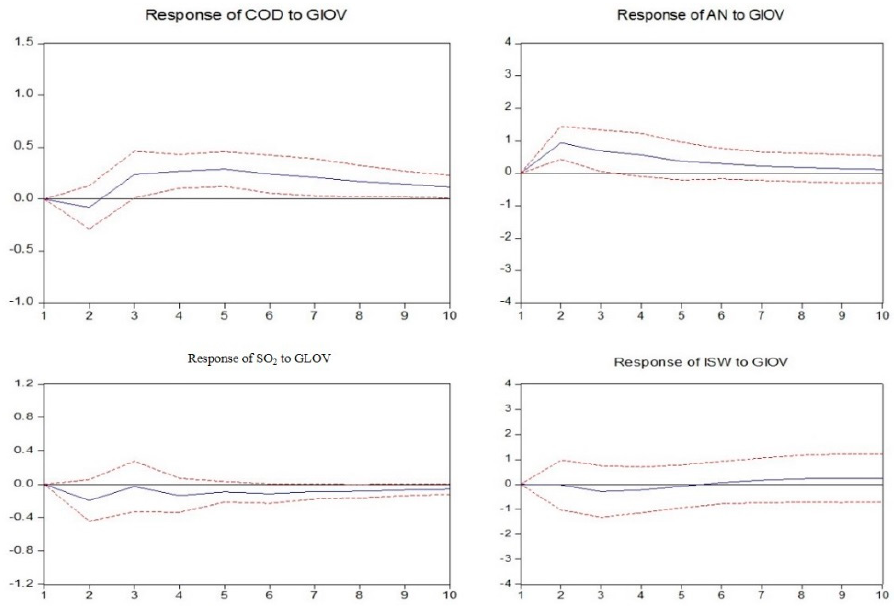
Figure 8. Responses of pollutants charged to industrial output value of mining and washing of coal. The solid lines indicate the mean responses to a one standard deviation shock, while the dotted lines represent ± 2 standard deviations of the responses.